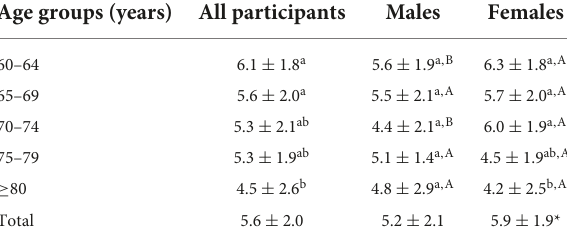
TABLE 2 Comparison of smell identification score between age groups and gender in 670 older adults.